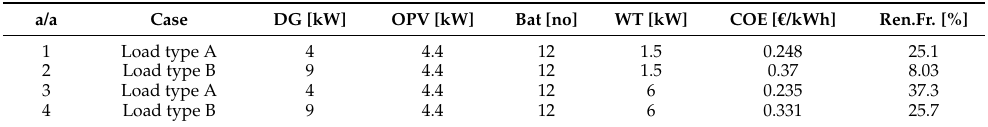
Table 6. Optimization results of base cases using different